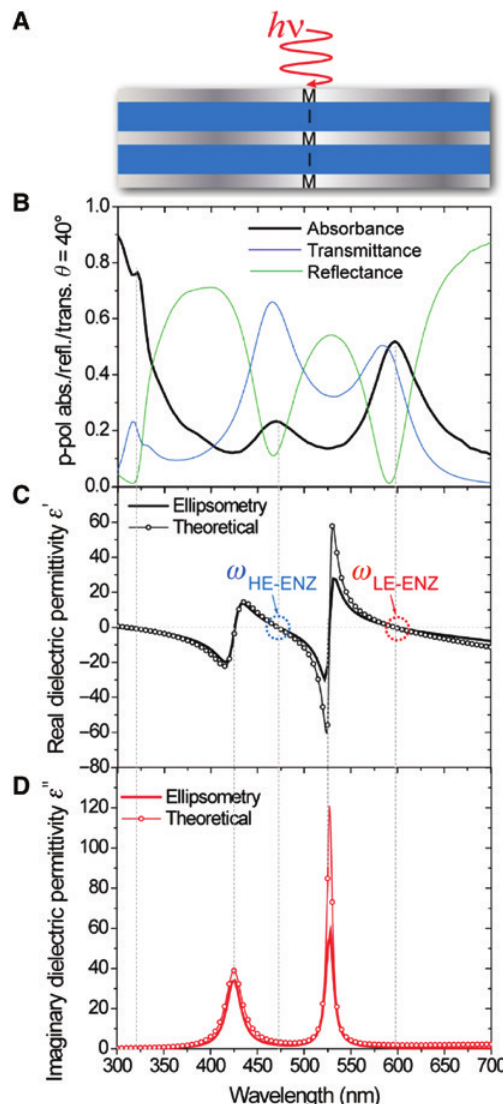
Figure 1: Optical properties of the MIMIM structure. (A) Architecture of the MIMIM structure with illumination from the top. (B) Ellipsometrically measured p-polarized transmittance (blue), reflectance (green), and absorbance (black), detected at θ = 40 ° , showing two absorbance maxima at the two low-loss ENZ wavelengths. (C and D) Theoretically modeled (empty circles) and ellipsometrically measured (solid line) real (C) and imaginary (D) effective dielectric permittivity of an MIMIM cavity. Low-loss ENZ wavelengths are highlighted with blue (high-energy) and red (low- energy) dashed